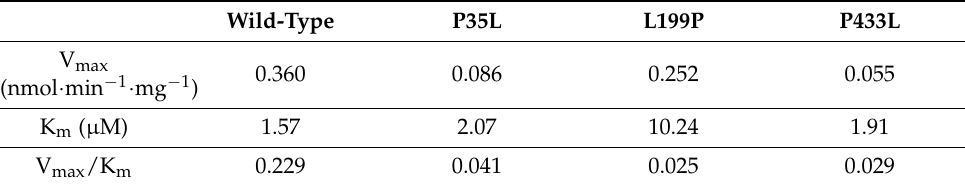
Table 5. Apparent kinetic constants and catalytic efficiency were calculated from three independent